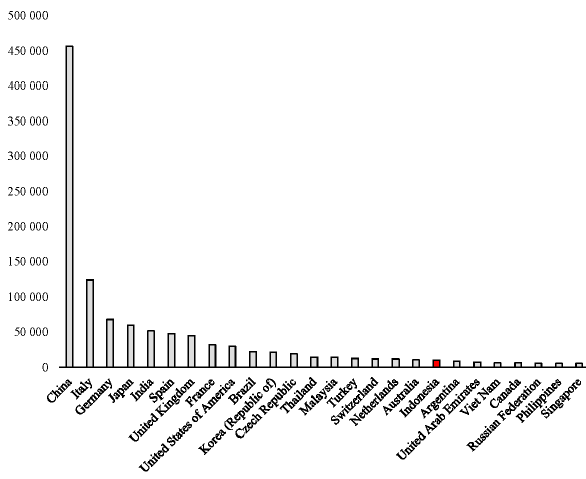
Figure 5: Comparison of the total management system certificates awarded in each country in 2019